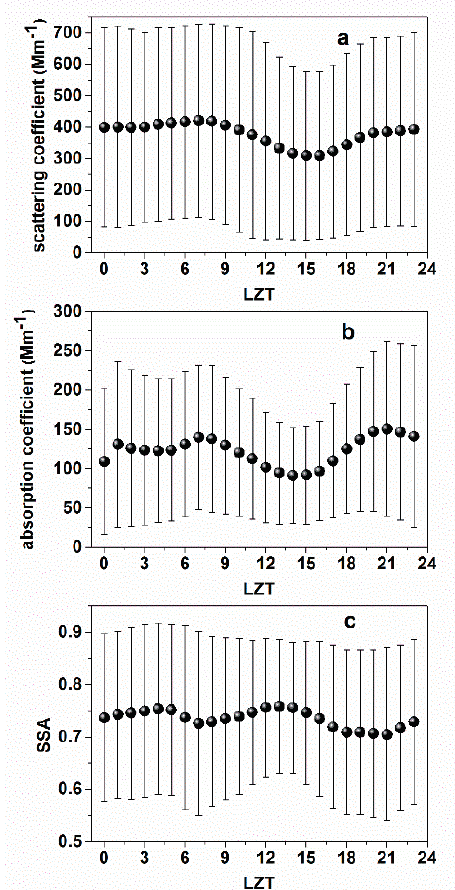
Figure 8. Diurnal changes in aerosol optical properties at the Laboratory for Information Engineering in Surveying, Mapping and Remote Sensing (LIESMARS) site. The short horizontal lines represent the standard deviation: ( a ) aerosol scattering coefficients ( σ ( b ) aerosol absorption coefficients ( σ ); ( c ) single scattering albedo (cid:2911)(cid:2912)